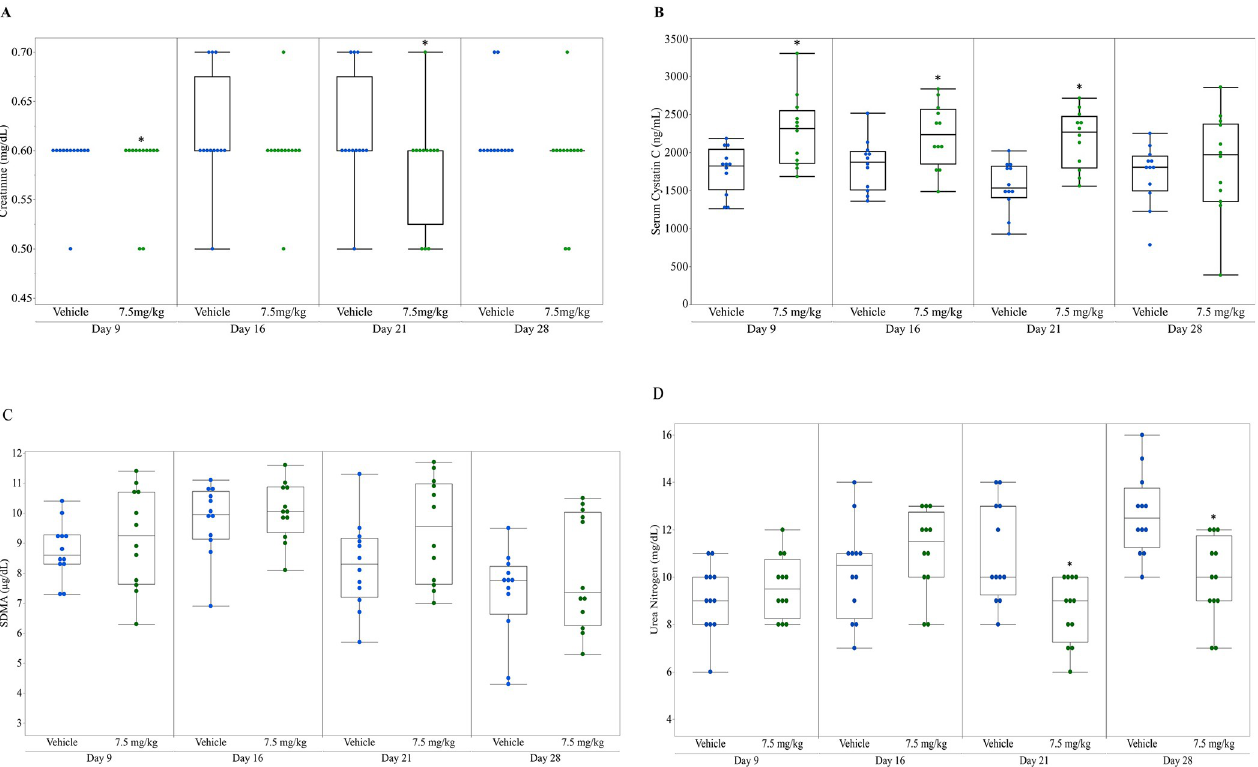
Fig 1. Serum excretory renal function biomarkers in control and anti-Fx1A-treated rats. A. Creatinine (mg/dL); B. Cystatin C (ng/mL); C. SDMA ( μ g/dL); D. Urea nitrogen (mg/dL). Outlier boxplot: Horizontal line within the box represents the median sample value, box represents interquartile range (IQR), whiskers extend to 1.5x IQR. � Indicates treatment group is significantly different (p � 0.05) from vehicle control group at the same number of doses.